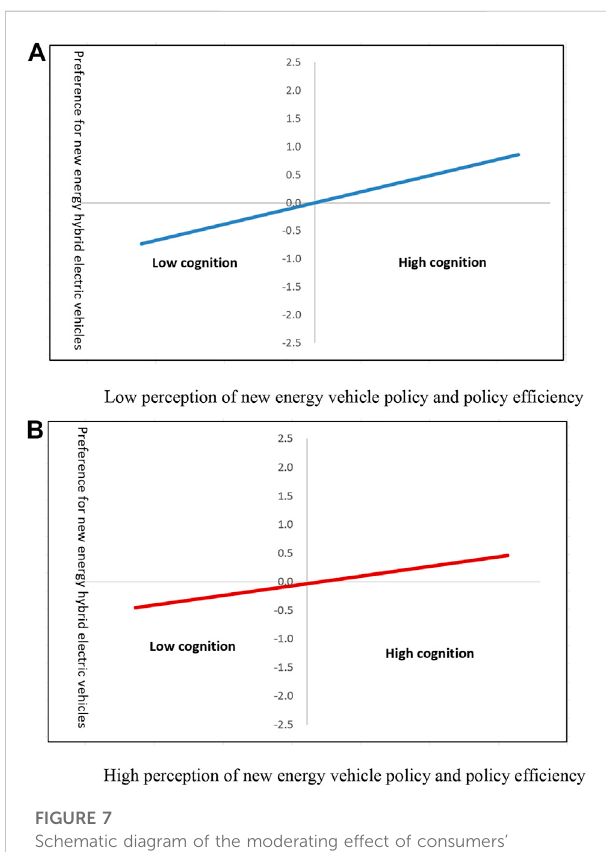
FIGURE 7 Schematic diagram of the moderating effect of consumers ’ perception of low-carbon policies and the ef fi ciency of policy